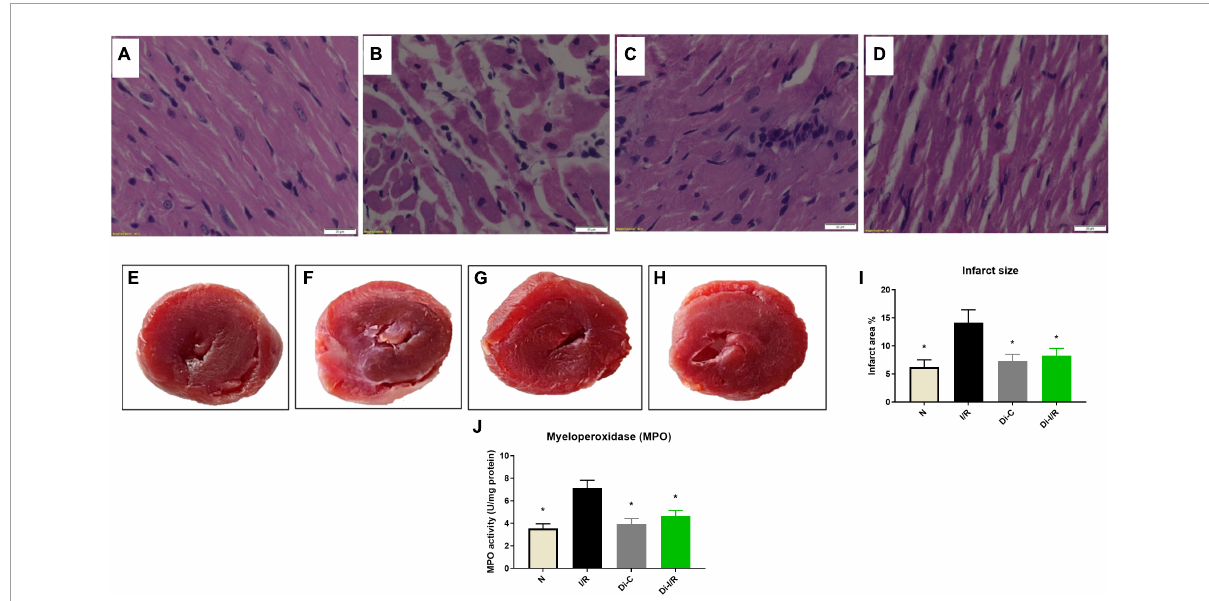
FIGURE2 Targeting DNA methylation via its inhibitor improved the I/R-altered myocardial histology and reduced the infarct size; and blood MPO levels. Histopathological examination of myocardium in LAD model from rat hearts of group (A) normal; (B) I/R; (C) Di-C; (D) Di-I/R. The representative images were obtained at 40 × magnification and the scale bars indicate 20 µ M. The representative TTC stained images subjected to the perfusion protocol as per the groups: (E) Normal; (F) I/R; (G) Di-C; (H) Di-I/R; (I) represents the percentage of infarct size; (J) represents MPO activity in blood. The graph represents the mean ± SD of the percentage of the area of infarct size. * p < 0.05 vs. I/R.